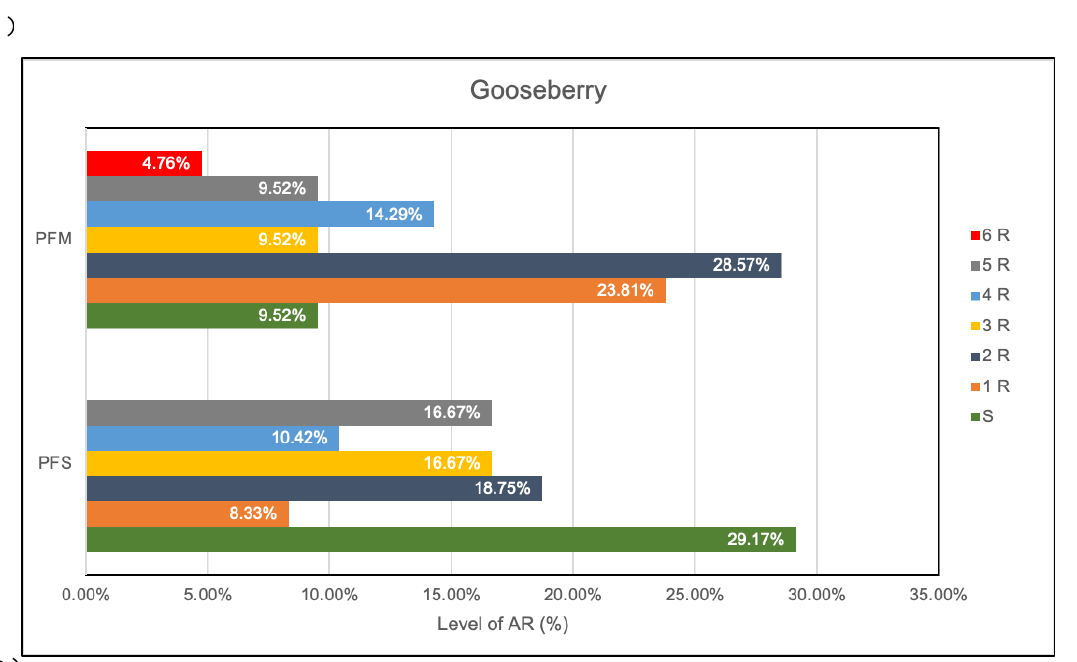
Figure 4. Level of AR (%) in juices. The bars represent the % of bacteria that showed resistance. 2.4. Hemolytic Phenotype of Selected MDR Isolates Numerous bacterial species produce hemolysins, which are regarded as a crucial el- ement of pathogenicity. To provide the toxin-producing bacteria with nutrients, especially iron, these chemicals break membranes, cause cells to lyse, and kill adjacent cells and tis- sues [34]. In this study, a considerable number of isolates associated with fruits and juices were beta-hemolytic according to the transparent zone to surround bacterial colonies on 0.00